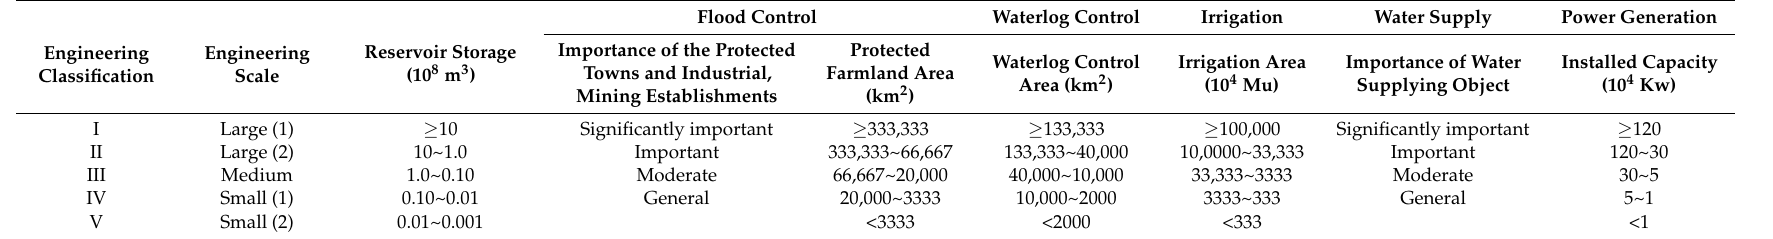
Table 1. Classification index of reservoir